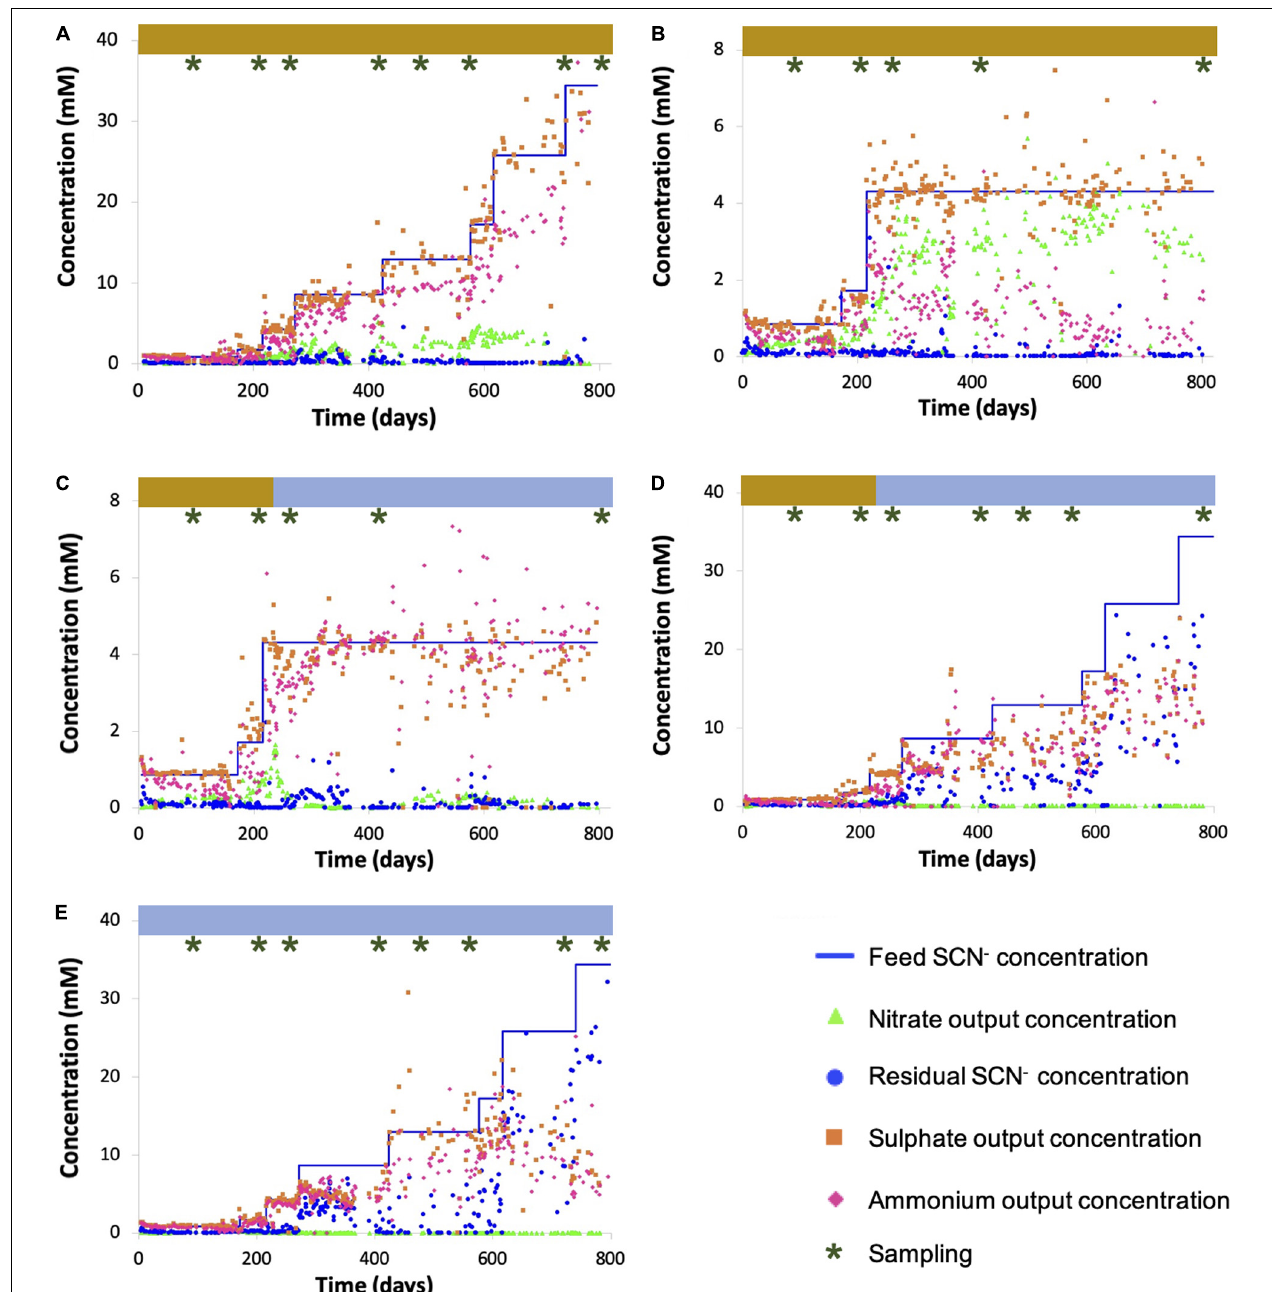
FIGURE 1 | Chemical parameters for R1 (A) , R2 (B) , R3 (C) , R4 (D) , and R5 (E) . Sampling time points for total DNA extractions are indicated above plots (brown shading indicates mollases supplements feed, while the blue indicates a water-based feed).